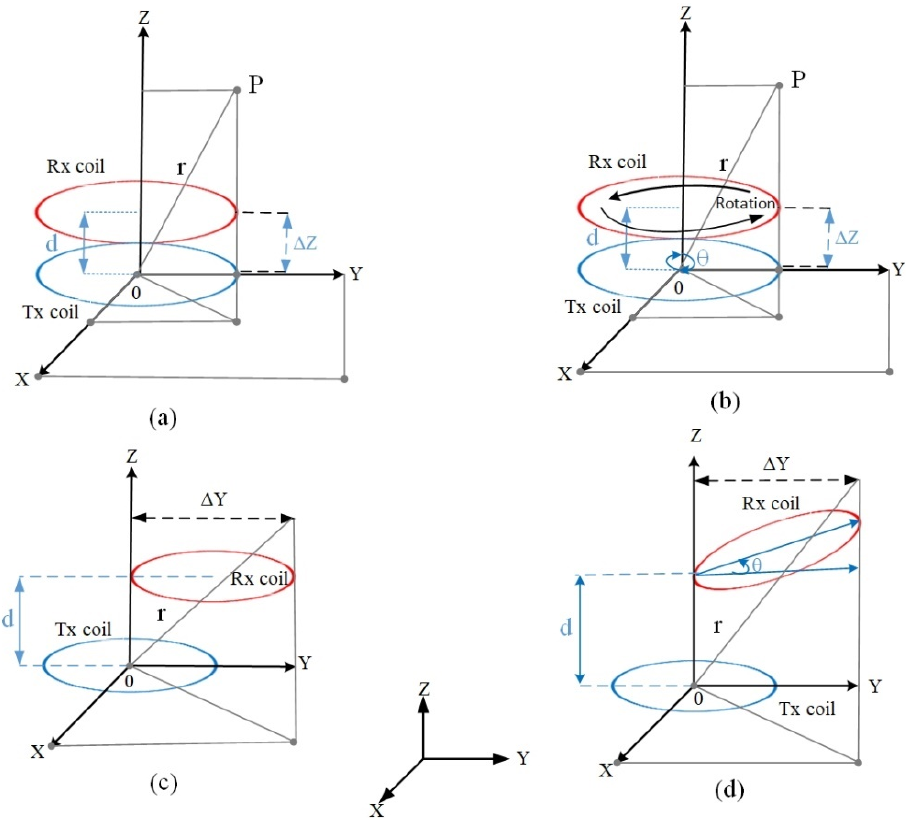
Figure 1. Schematics of circular coils for analyzed variations: ( a ) ideal alignment (vertical variation); ( b ) planar variation; ( c ) lateral misalignment; and ( d ) angular in lateral misalignment.